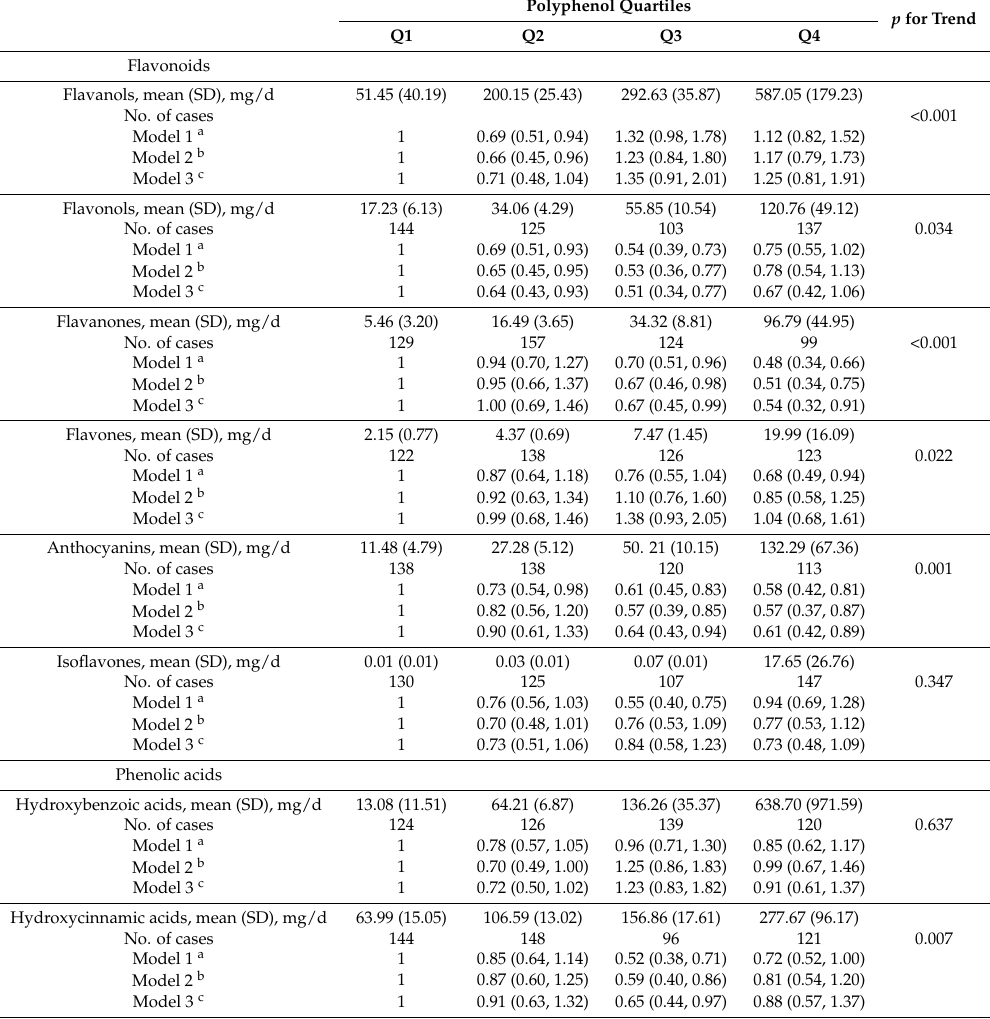
Table 3. Odds ratios (ORs) and 95% confidence intervals (CIs) for the association between flavonoid and phenolic acid subclasses and depressive symptoms.